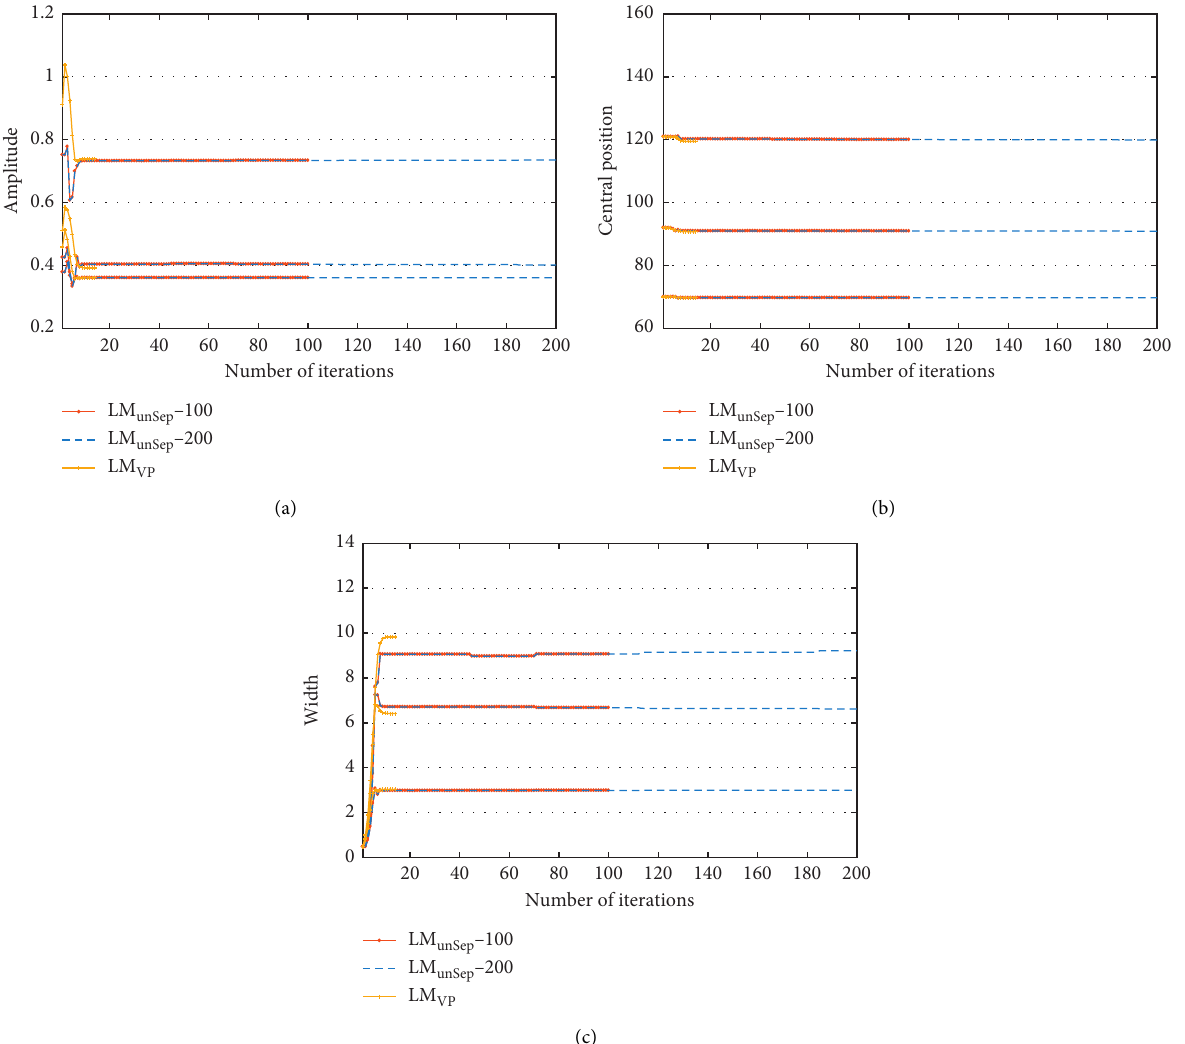
Figure 5: Parameter iterative process for calculating (a) a , (b) μ , and (c) σ from the satellite data in the real experiment involving the two